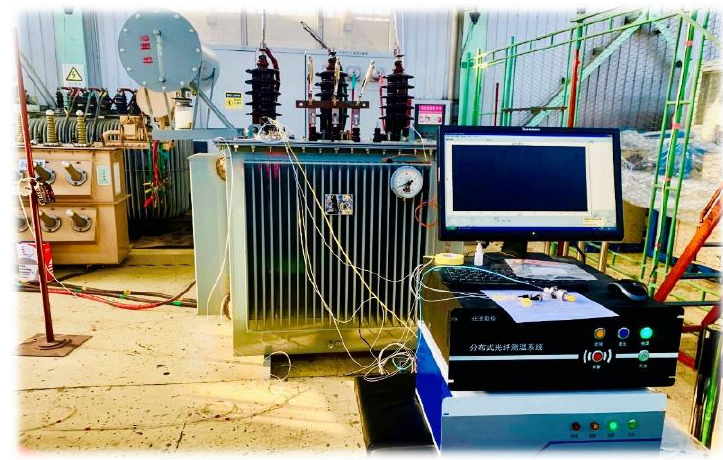
Figure 5. Field temperature online monitoring.